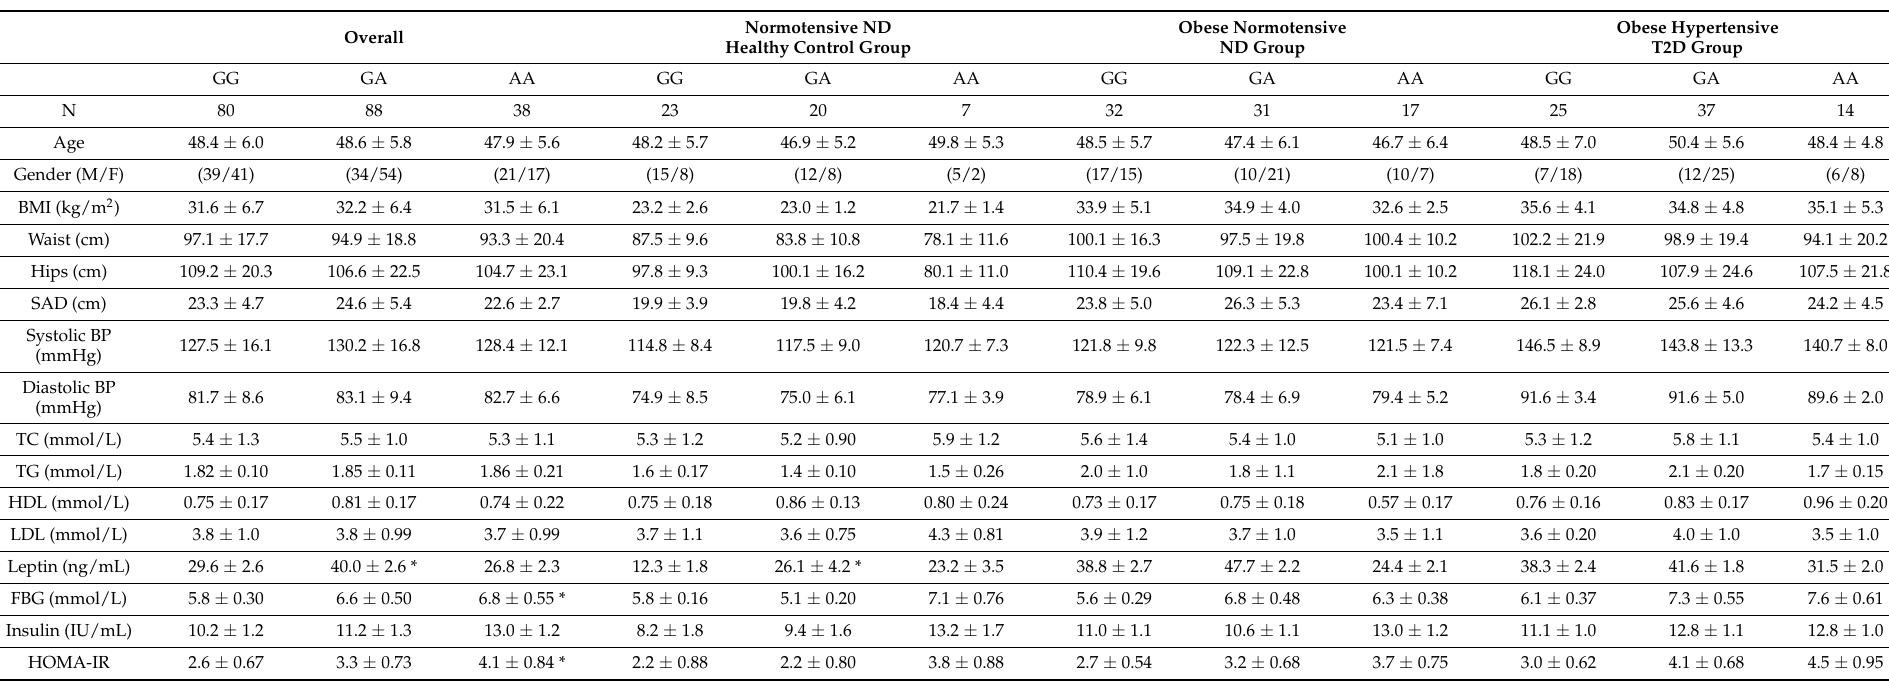
Table 3. Anthropometric and clinical characteristics of the study population with respect to the -2548G/A LEP polymorphism.